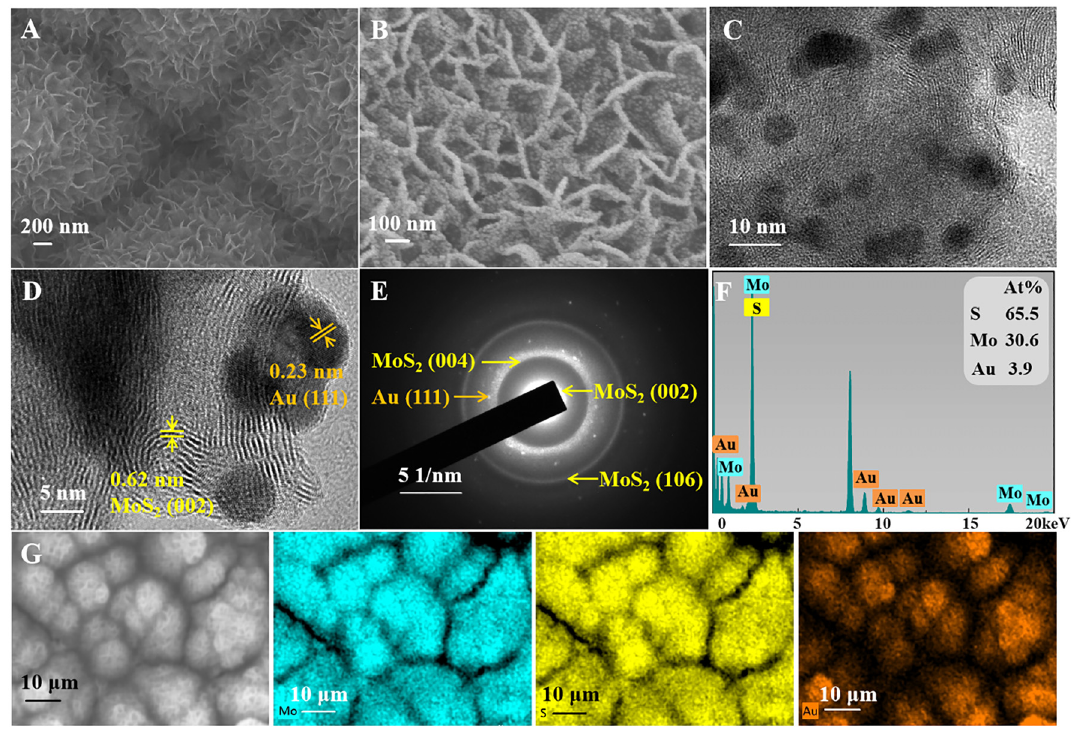
Figure 1: Structural characterization of molybdenum disulfide (MoS 2 )-based substrates. Scanning electron microscope (SEM) morphology characterization of (A) pyramid Si (PSi)/MoS 2 and (B) PSi/MoS 2 /Au multiscale cavity (MSC) substrate. (C) Transmission electron microscope (TEM) image of Au nanoparticles (AuNPs) decorated on the MoS 2 nanosheets. (D) High- resolution transmission electron microscope (HRTEM) image of AuNPs decorated on the MoS 2 nanosheets. (E) The selected area electron diffraction (SAED) pattern of MoS 2 /Au. (F) The corresponding energy-dispersive spectrometer (EDS) spectrum. (G) EDS elemental maps from Mo, S, and Au on the PSi/MoS 2 /Au MSC